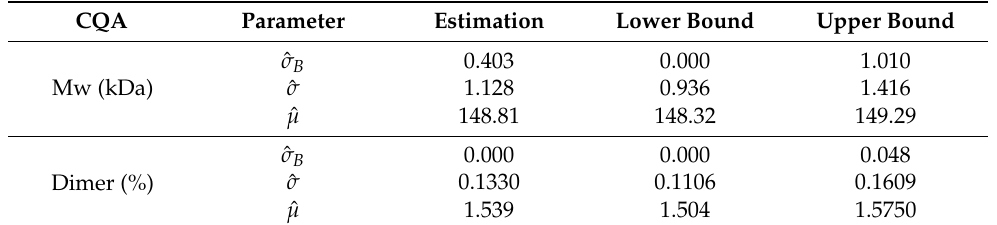
Table 2. Maximum likelihood method estimates and their corresponding 95% confidence intervals.